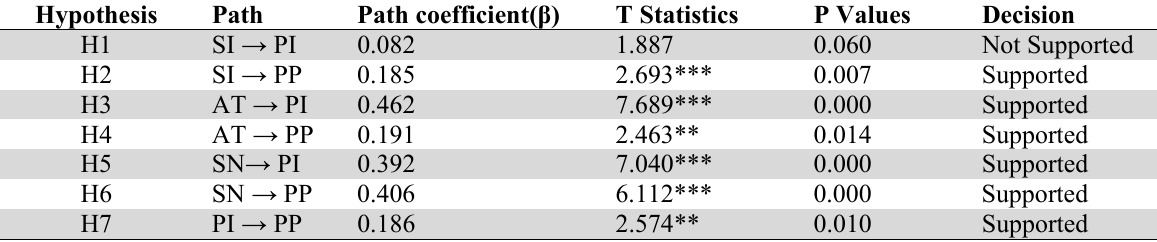
Fig. 2. PLS Algorithm Path Model Structural Relationships and Hypothesis